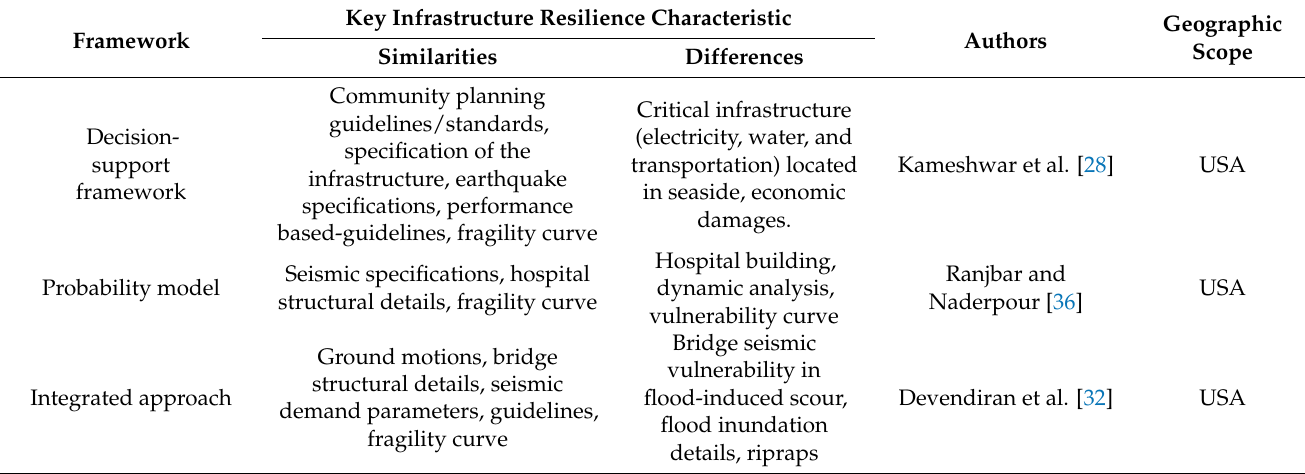
Table 3. The similarities and differences in the framework with similar geographic